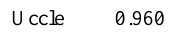
Table 8. Kendall’s tau τ K for couple of D and S . Data set